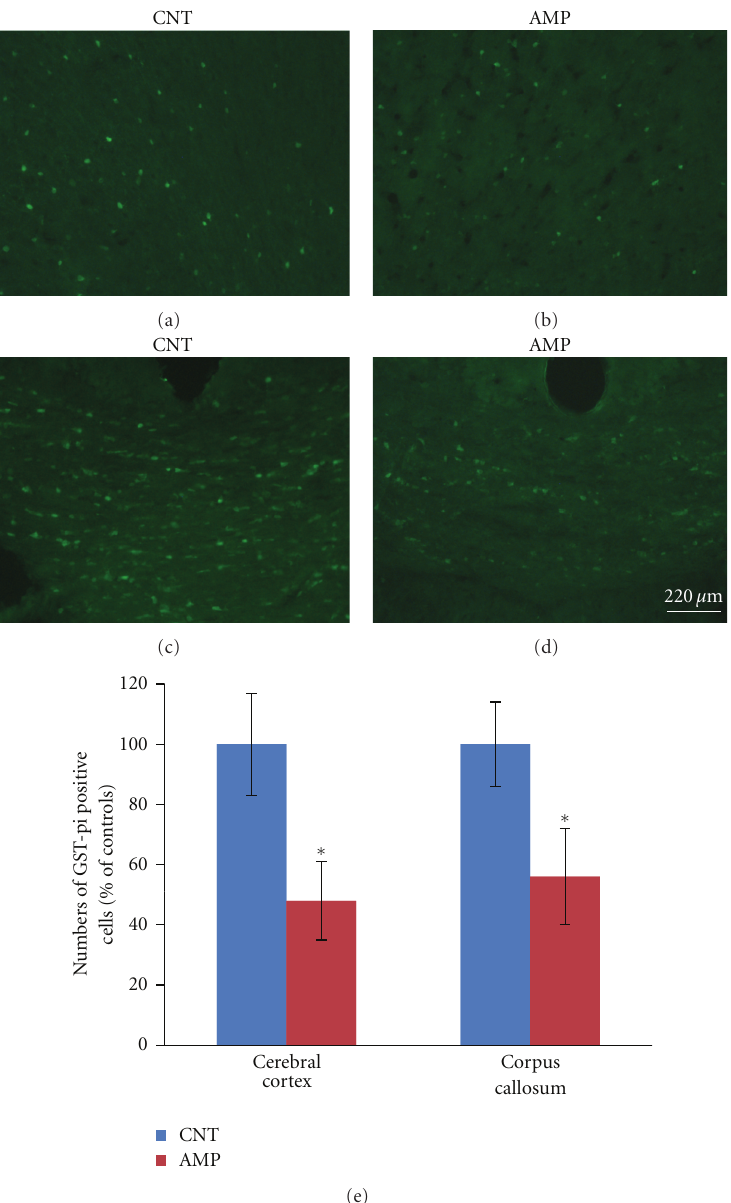
Figure 5: AMP reduced the numbers of GST-pi positive cells in cerebral cortex and corpus callosum. After treating with d-AMP or a same volume of saline for 21 days and subjected to behavioral tests, mice were sacrificed and their brains were processed for immune-fluorescent staining. The numbers of GST-pi positive cells in cerebral cortex and corpus callosum were counted. All AMP-treated mice had decreased GST-pi cells than the average of CNT group. Representative photographs were presented and labeled. Quantitative data were statistically analyzed and presented in a bar chart. Data were expressed as means ± SEM. Comparisons were made between CNT and AMP groups. ∗ P < 0 .